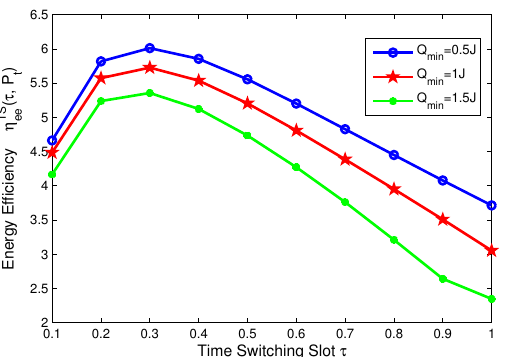
Figure 16. Energy efficiency versus power splitting ratio with different minimum harvested energy requirements for TS